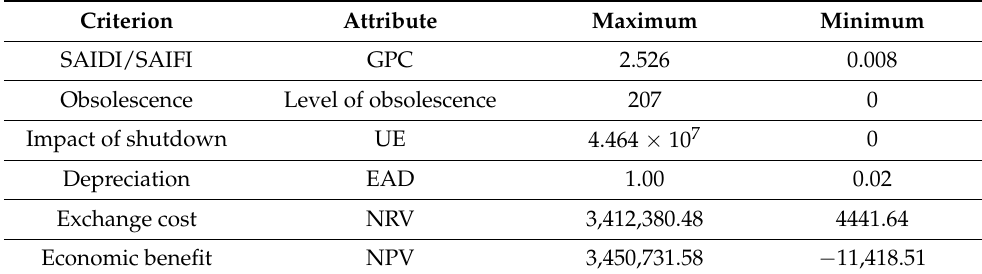
Table 8. Maximum and minimum values of the evaluated